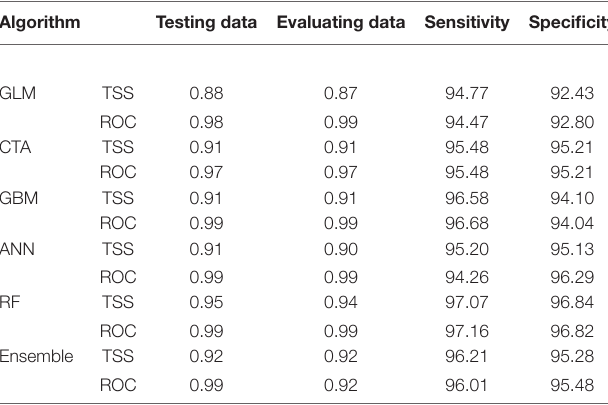
TABLE 3 | Statistics of evaluation for the OccurrenceSDM ensemble, and each of the five individual algorithms used to develop the ensemble.